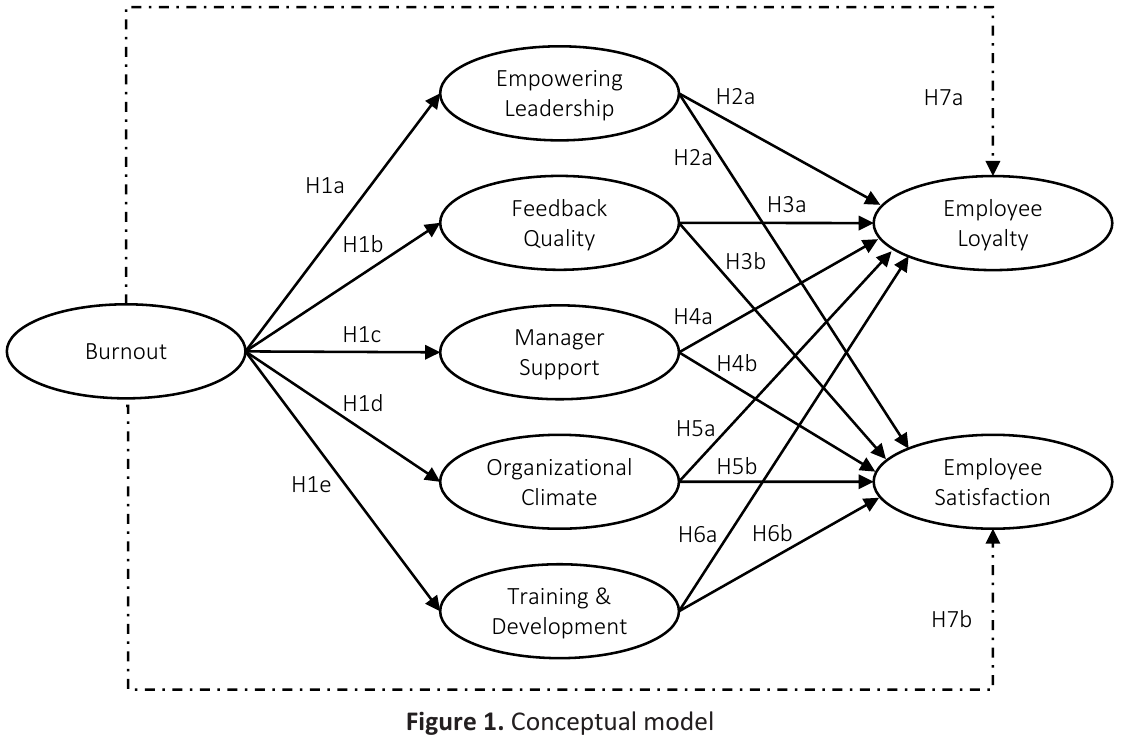
Figure 1. Conceptual